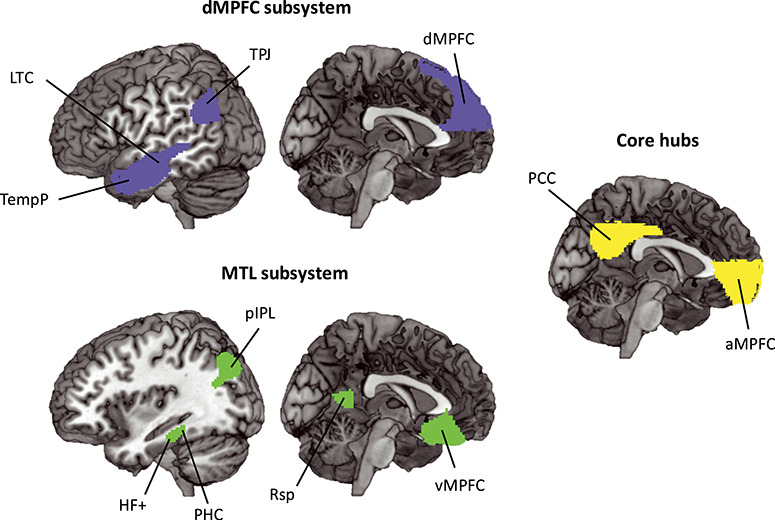
DMN ROIs used in the current experiment. The ROIs are derived from networks 10, 15, 16, and 17 described in the 17 network parcellation in Yeo et al. (2011) and divided according to coordinates described in Andrews-Hanna et al. (2010). Regions in blue are part of the dMPFC subsystem, and include the midline dMPFC and bilateral TPJ, LTC, and TempP. Regions in green are part of the MTL subsystem, and include the midline vMPFC and bilateral pIPL, Rsp, PHC, and HF+. The core hubs are represented in yellow, and include the bilateral aMPFC and PCC. For abbreviations, see Table 1.